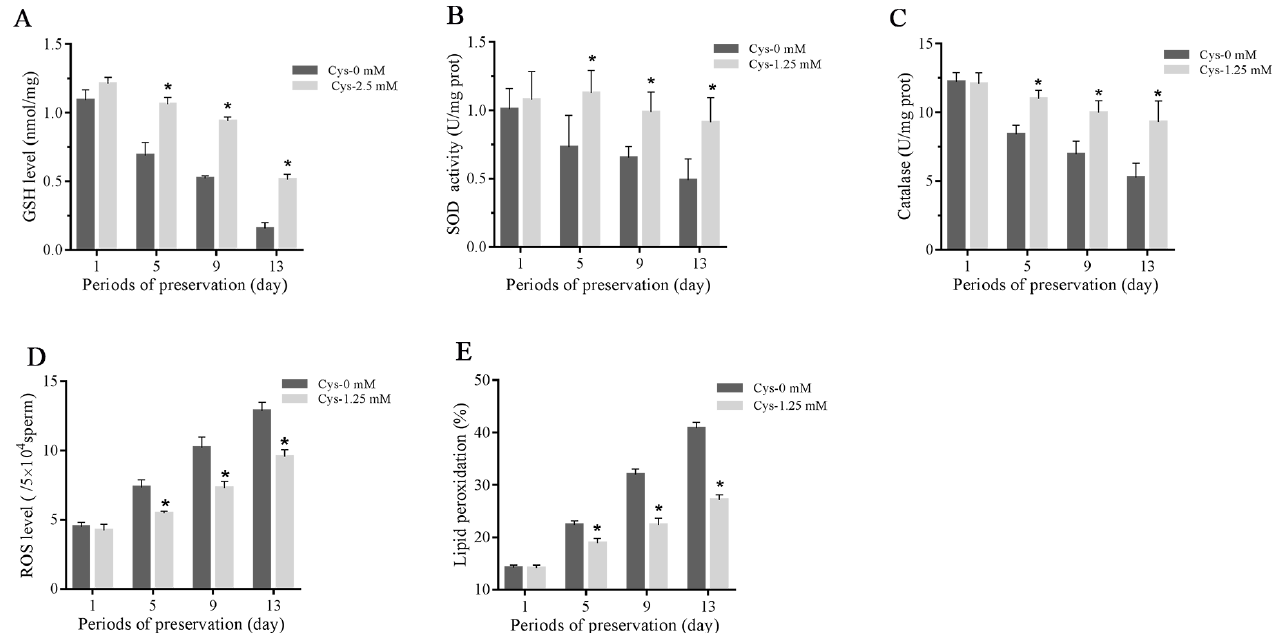
Figure 2. Effects of cysteine on sperm GSH level (A), activities of SOD (B) and catalase (C), ROS level (E) and lipid peroxidation (F) after 13 days’ preservation. Values are specified as mean±standard deviation (SD). GSH, glutathione; SOD, superoxide dismutase; ROS, reactive oxygen species; Cys, cysteine. * Denotes significant differences compared with the control (p<0.05).